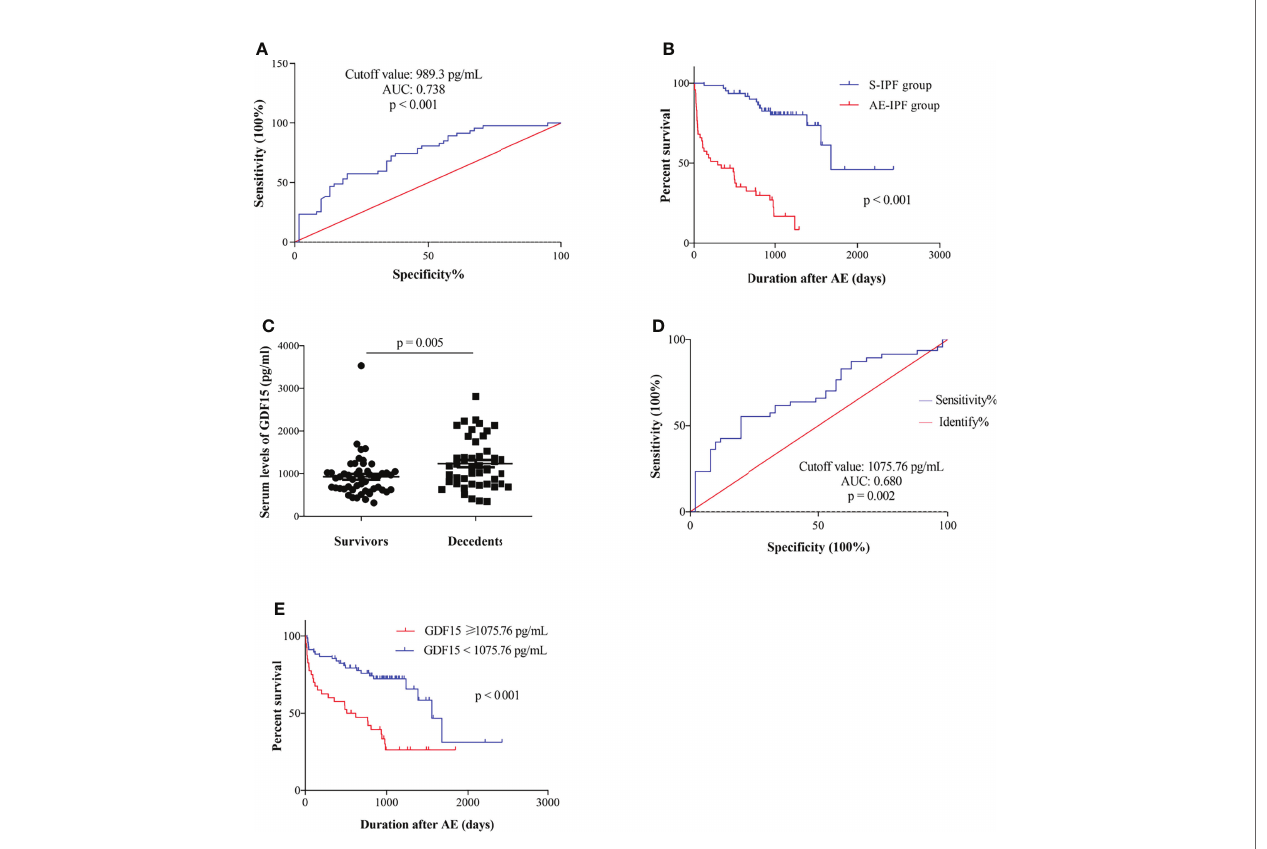
FIGURE 3 | Serum GDF-15 can predict AE occurrence and survival in IPF patients independently. (A) The areas under ROC curves of GDF-15 were statistically signi fi cant in the classi fi cation of AE-IPF subjects (n = 47) or S-IPF patients (n = 61) (ROC: 0.738, p < 0.001, 95%CI: 0.529-0.809, cut-off value 989.3 pg/ml). (B) The AE-IPF patients had a signi fi cantly greater mortality compared with S-IPF cases by Kaplan – Meier analyses (p < 0.001). (C) Serum GDF-15 was signi fi cantly increased in decedents (n = 47) than that in survivors (n = 51) (p = 0.005). (D) ROC curve analyses for predicting the death of IPF patients based on serum GDF-15 levels. The areas under the ROC curve of GDF-15 were statistically signi fi cant in identifying the decedent from the survivor (ROC: 0.680, p = 0.002, 95%CI: 0.572-0.787, cut-off value 1075.76 pg/ml). (E) Patients with serum GDF-15 levels above 1,075.76 pg/ml had a higher mortality than those with GDF-15 levels lower than that (p < 0.001).